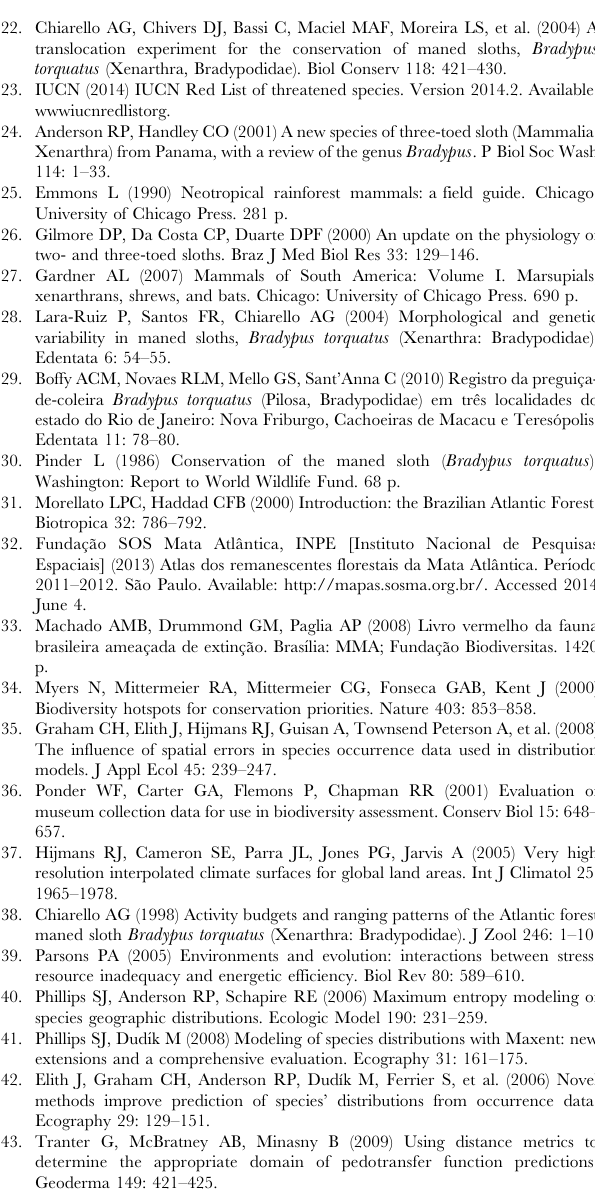
Table S2 Environmental variables values for the 42 presence points of maned sloth. The values are from each environmental variable pixel coincident with the records points of the maned sloth ( Bradypus torquatus ). Sergipe (SE), Bahia (BA), Espı´rito Santo (ES), Rio de Janeiro (RJ). Elevation (ELV), mean monthly temperature range (TMR), temperature seasonality (TS), maximum temperature of warmest month (TWM), minimum temperature of coldest month (TCM), temperature annual range (TAR), annual precipitation (PA), precipitation of wettest month (PWM) and precipitation of driest month (PDM). Points records localities are available (Table